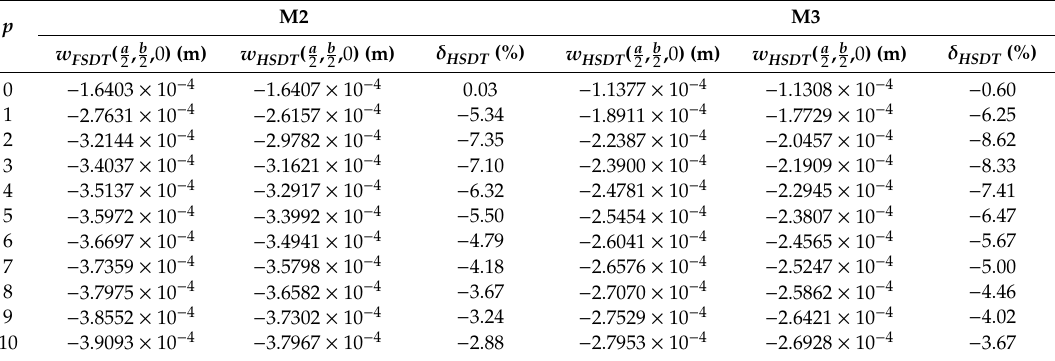
Table 10. Porosity distribution models M2 and M3: plate’s center transverse displacement for different shear deformation theories.